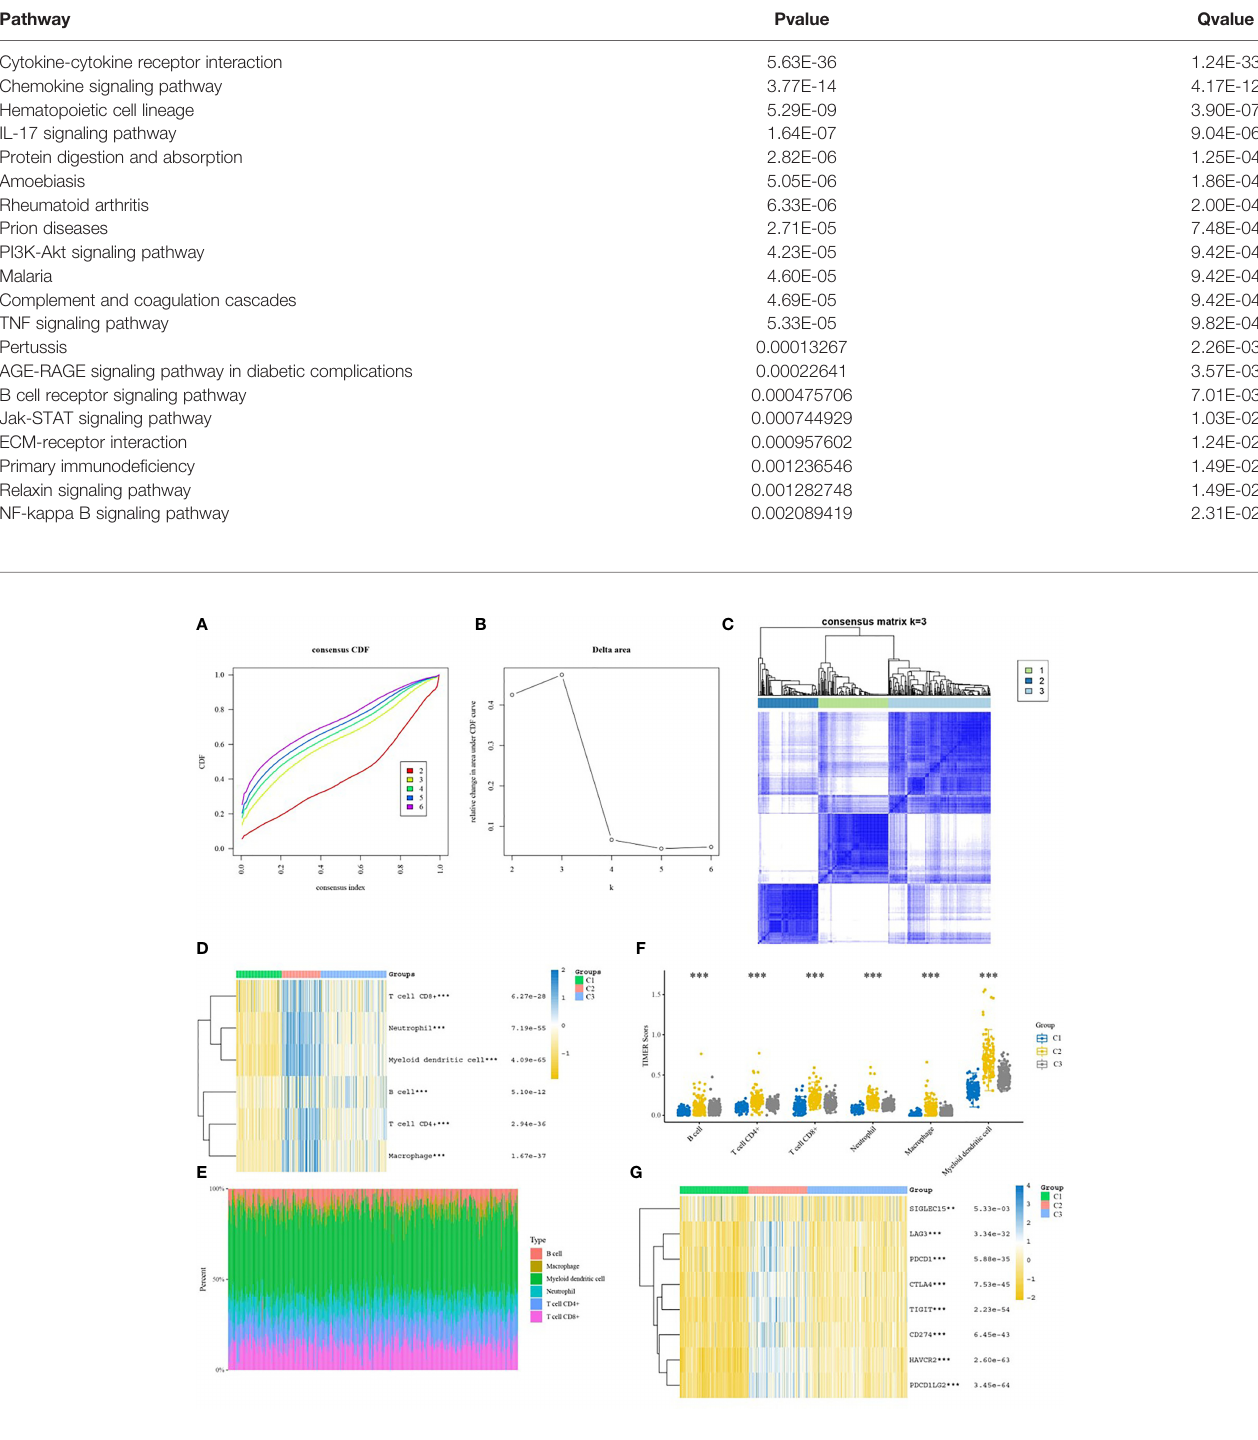
FIGURE 3 | Immunoclustering analysis of colon cancer subgroups. (A) CDF graph; (B) CDF Delta area graph; (C) Consensus matrix heat map of the three sample clusters de fi ned with a consensus range of 0-1, with 0 representing white, meaning that the samples do not cluster, and 1 representing blue, meaning that the samples always cluster; (D) Heat map of the distribution of immune cells in different subgroups; (E) Percentage abundance of tumor-in fi ltrating immune cells in each sample, with different colors representing different immune cell types, horizontal coordinates represent samples, vertical coordinates represent the percentage of immune cell content in individual samples; (F) TIMER score distribution of 6 in fi ltrating species immune cells in different subgroups; (G) Heat map of the distribution of immune checkpoint genes in different subgroups. *p < 0.05, **p < 0.01, ***p <